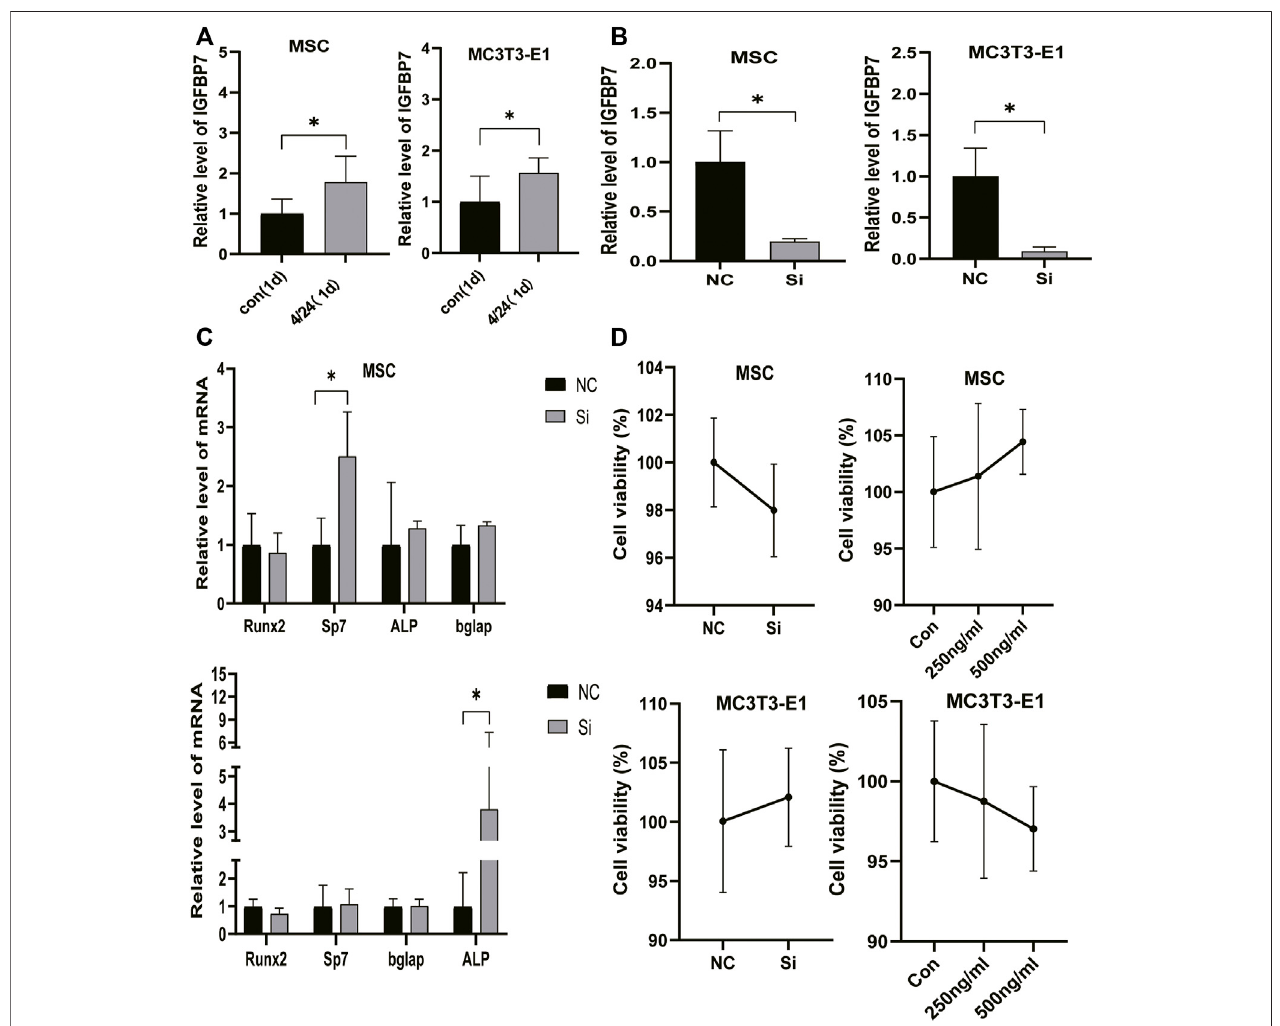
FIGURE 2 | Veri fi cation of IGFBP7 knockdown in BMSCs and MC3T3-E1 cells. (A) The expression of IGFBP7 mRNA induced by iPTH for 4/24 h on d one in BMSCs and MC3T3-E1 cells. (B) Establishment of IGFBP7 knockdown in BMSCs and MC3T3-E1 cells. (C) Relative mRNA expressions of osteogenic marker genes at 48 h after transfection in BMSCs and MC3T3-E1 cells in the negative control group (NC) and IGFBP7 silenced group (Si). (D) BMSCs and MC3T3-E1 cell proliferation was examined by the CCK-8 assay. * p < 0.05.